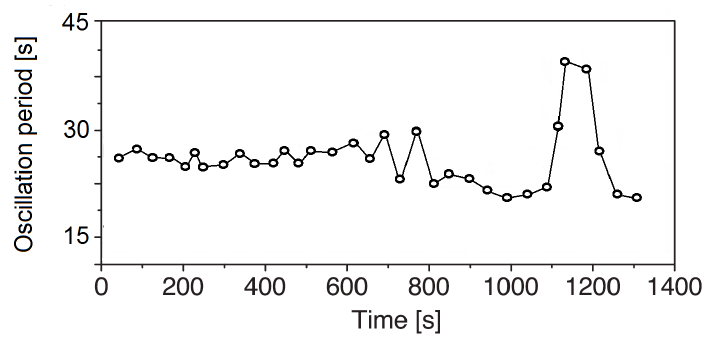
Figure 4. Time evolution of the oscillation period for an aqueous isopropyl alcohol solution at C 0 = 6